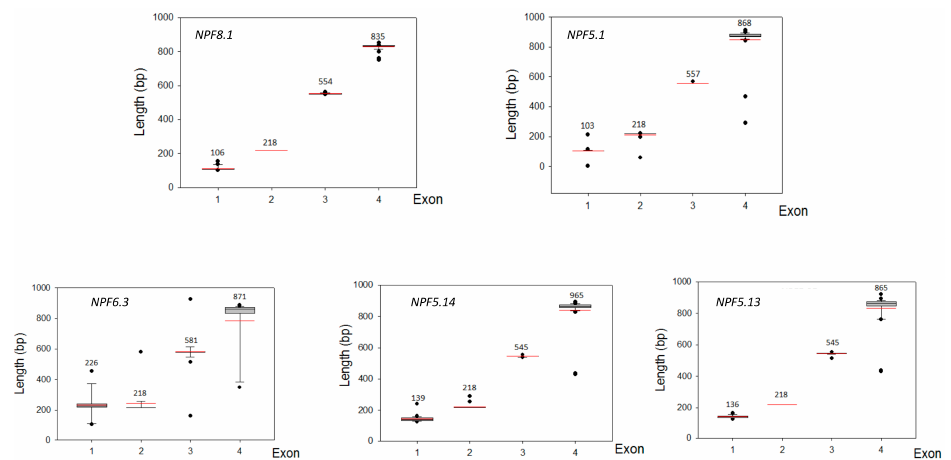
Figure 5. Exon-length distribution for NPF5.1 , NPF6.3 , NPF5.13 , NPF5.14 , and NPF8.1 in different plant species. Analysis was based on Boxplot depictions in SigmaPlot 12.0 program. Each box represents exon size range in which 50% of values for particular exon are grouped. Mean value is indicated by long red line.